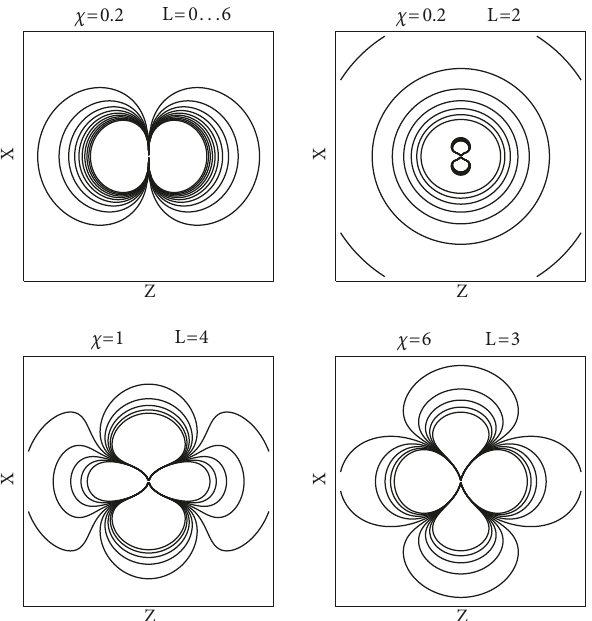
Figure 1: Equipotential contours of the effective potential 𝑉(𝑥,𝑧) at 𝑦 = 0 , as given by Eq. (15). The dipole is along 𝑧 -axis. Several values for dipole strength 𝜒 and 𝐿 . For 𝐿 = 0 the potential geometry is the same for any dipole strength, but for higher magnetic field the equipotential shapes become complicated and